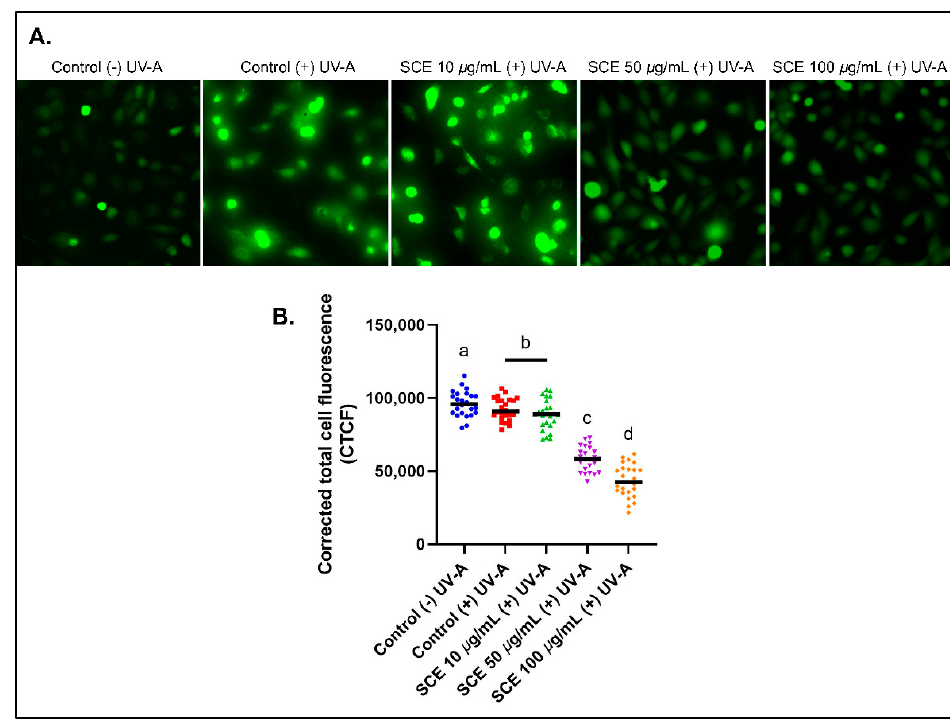
Figure 2. Reactive Oxygen Species (ROS) in B16-F10 cells detected using a H 2 DCFDA fluorescence probe. ( A ) B16-F10 cells emit green fluorescence after UV-A irradiation for 30 min. ( B ) The CTCF values show decreased fluorescence intensity with increased concentrations of SCE in B16-F10 cells, thereby, indicating a decrease in the cellular ROS levels. The results are represented as the means of three independent experiments (SEM ± SD). Different letters indicate a significant difference between treatments ( p < 0.05).